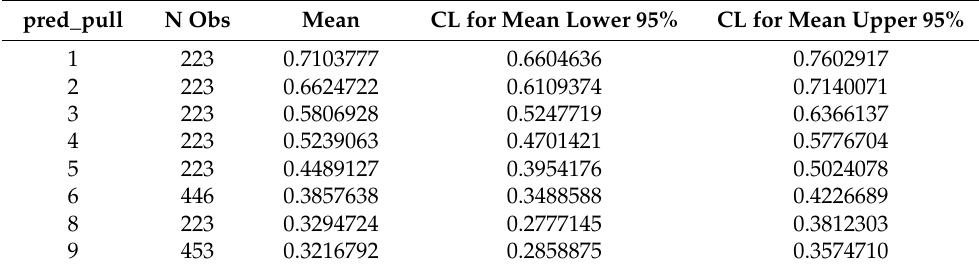
Table 5. Testing the Homogeneity of Survival